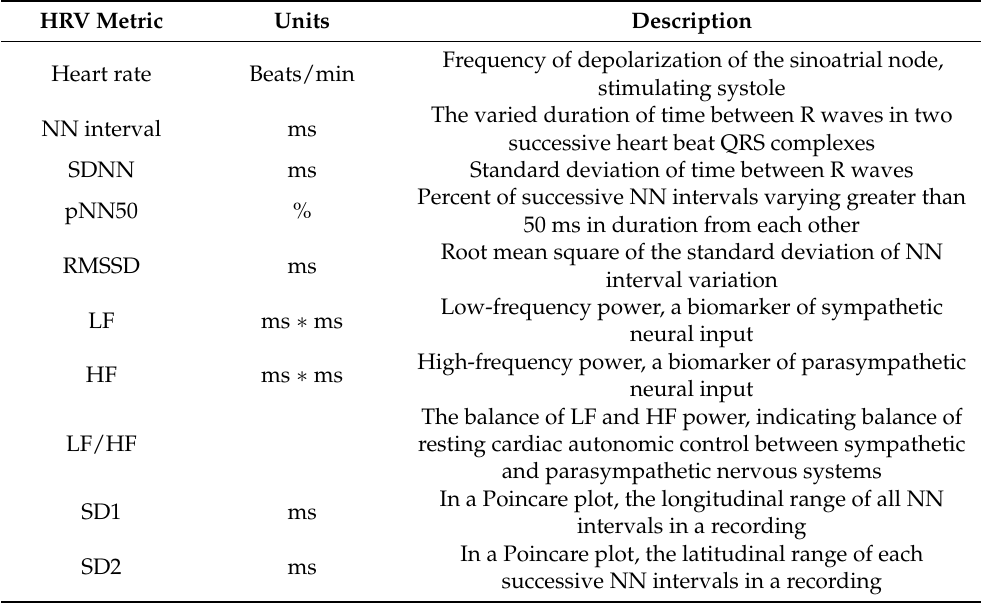
Table 2. Heart Rate Variability